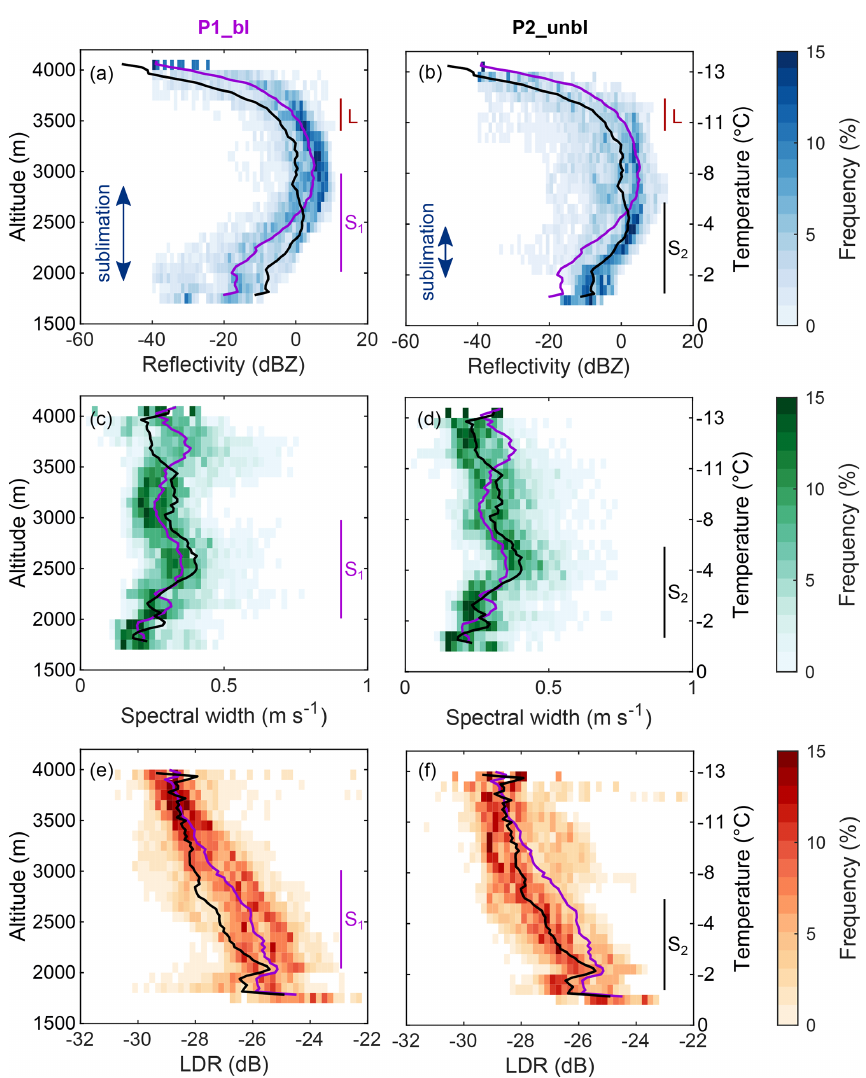
Figure 8. CFADs of the radar reflectivity (a, b) , spectral width (c, d) and linear depolarization ratio (e, f) averaged over sub-periods of P1_bl (left; 17:00–17:45UTC) and P2_unbl (right; 17:45–18:30UTC). The following bin sizes were applied: (1) radar reflectivity from − 40 to 20dBZ in 1dBZ intervals, (2) spectral width from 0 to 0.8ms − 1 in 0.02ms − 1 intervals and (3) LDR from − 32 to − 22dB in 0.2dB intervals. A height interval of 100m was used for all radar properties. The solid lines represent the mean vertical profile of P1_bl (purple) and P2_unbl (black). The temperature profile measured by the radiosonde is shown on the right y axis. The extent of the shear layer (S 1 , S 2 ; from wind profiler), the supercooled liquid layer (L; from cloud lidar) and the sublimation layer (blue arrow; from cloud radar) is indicated.